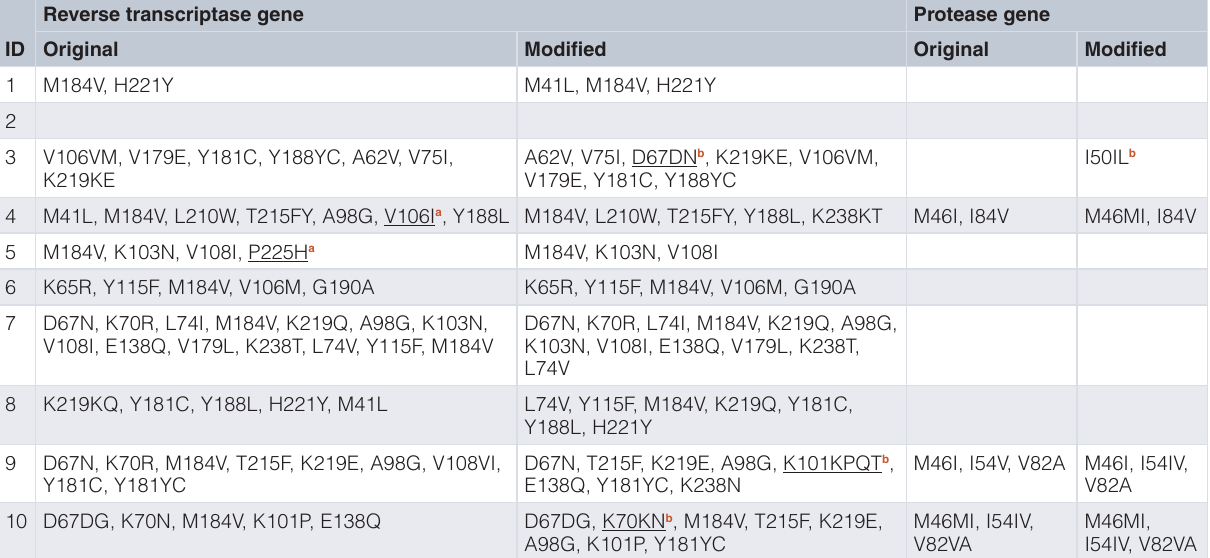
Table 3. Pairwise comparison of drug resistance mutations identified by the original assay with those identified by the modified